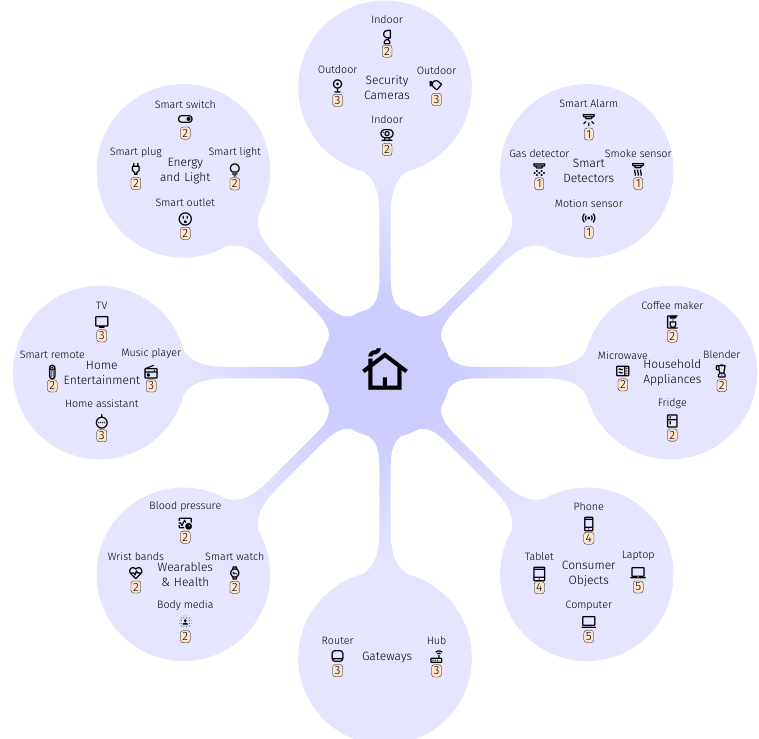
Figure 3. Smart home objects’